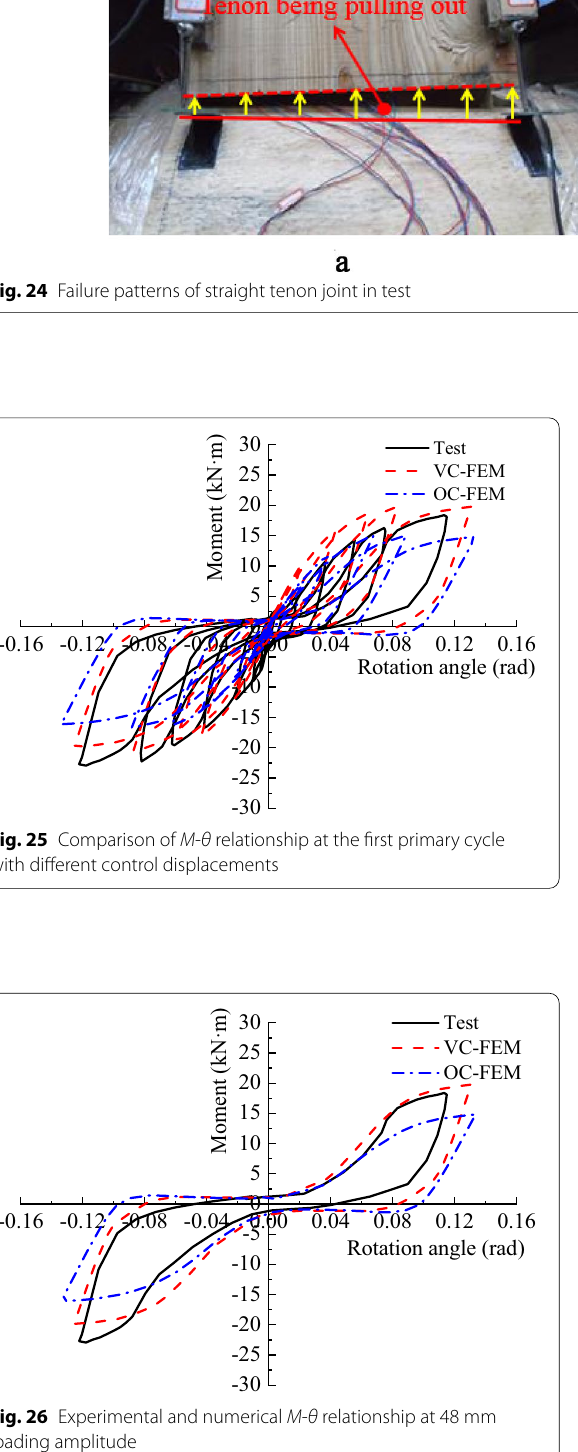
Fig. 26 Experimental and numerical M - θ relationship at 48 mm loading amplitude